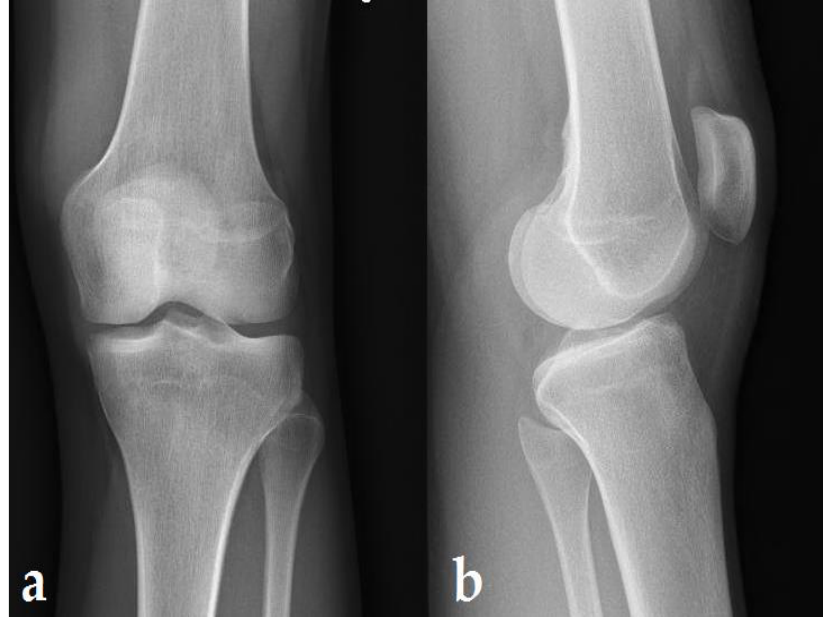
Figure 3. Standard X-rays: 4 months after the last US therapy. AP ( a ) and lateral view ( b ) showing no bone lesion. A further MRI performed 5 months after the previous one (6 months after US therapy ended) showed an apparent reduction in the bone abnormality lesions of the lateral fem- oral condyle, the lateral tibia plateau, and the proximal fibula (Figure 4).